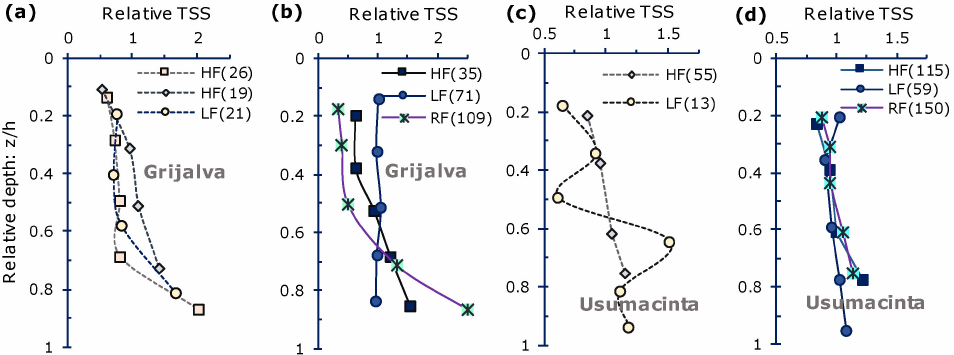
Figure 5. Total suspended solids (TSS) profiles. In panels ( a , c ), November 2016 (HF): squares; December 2016 (HF): diamonds; and April 2017 (LF): circles. In panels ( b , d ), November 2021 (HF): squares; April 2022 (LF): circles; August 2022 (RF): asterisks. HF: High flow; LF: Low flow; RF: Raising flow. Relative TSS are derived from the mean TSS (showed at parenthesis in